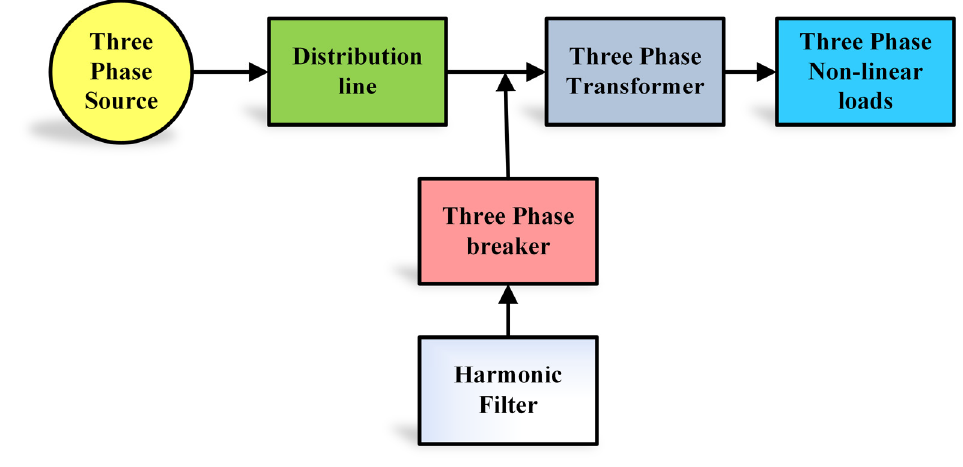
Figure 2. General block diagram representation of a power system considered for